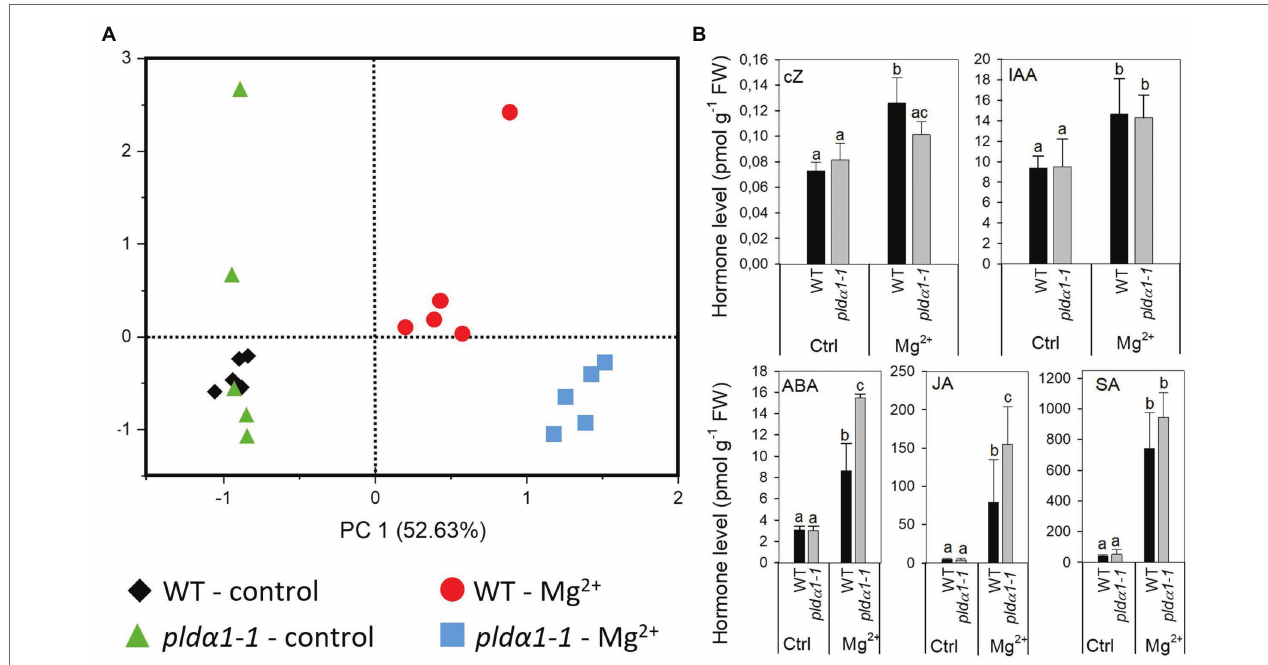
FIGURE 3 | Levels of plant hormone are altered in high-Mg 2+ conditions. (A) PCA analysis. (B) Level of cZ, cis-zeatin; IAA, indole-3-acetic acid; ABA, abscisic acid; JA, jasmonic acid; and SA, salicylic acid. Twenty-four-day-old hydroponically grown plants were treated with 15 mM MgSO 4 and grown for another 2 days. Leaves 3–6 were used for hormone analysis. Values represent means ± SD, n = 5, letters above the bars indicate significant differences, one-way ANOVA with Tukey’s post hoc test, p <